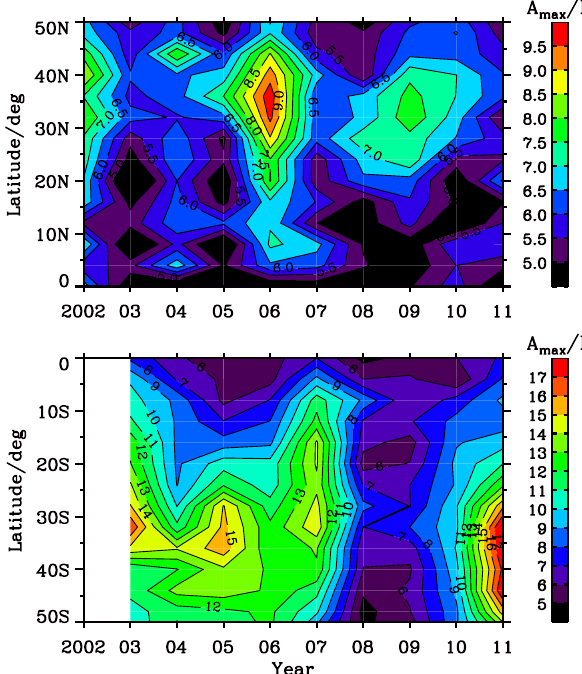
Fig. 7. Interannual variations of the strengths of (2.04, W4) in the NH (upper) and (2.13, W3) in the SH (bottom) in the mesosphere. Blank area denotes no